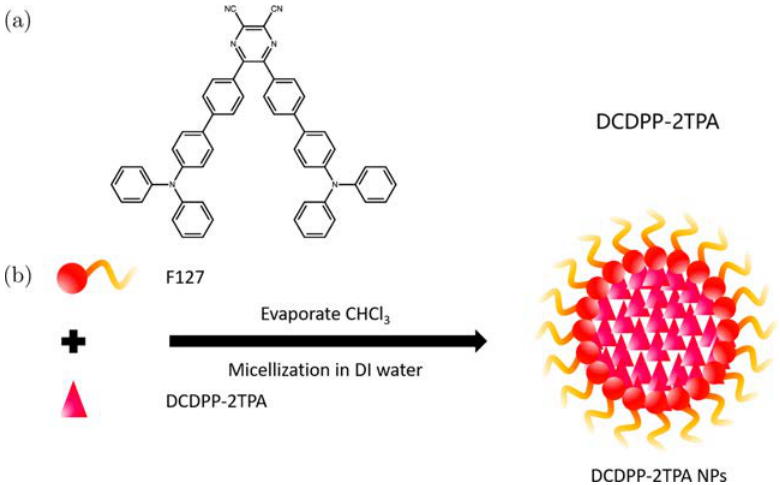
Fig. 2. (a) Chemical structure of DCDPP-2TPA. (b) Synthesis scheme of DCDPP-2TPA